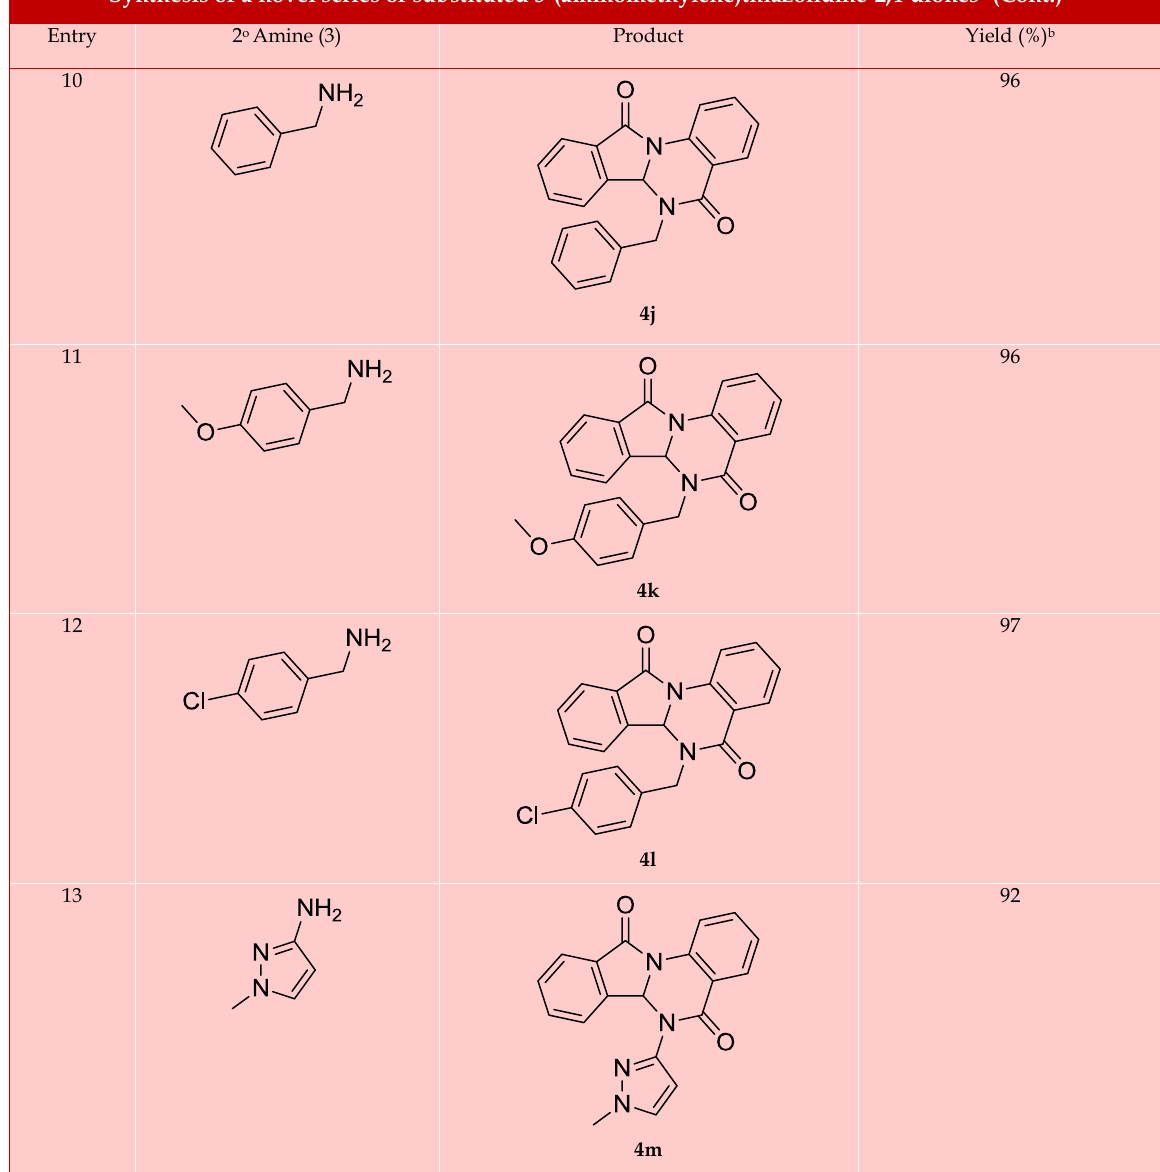
Synthesis of a novel series of substituted 5-(aminomethylene)thiazolidine-2,4-diones a